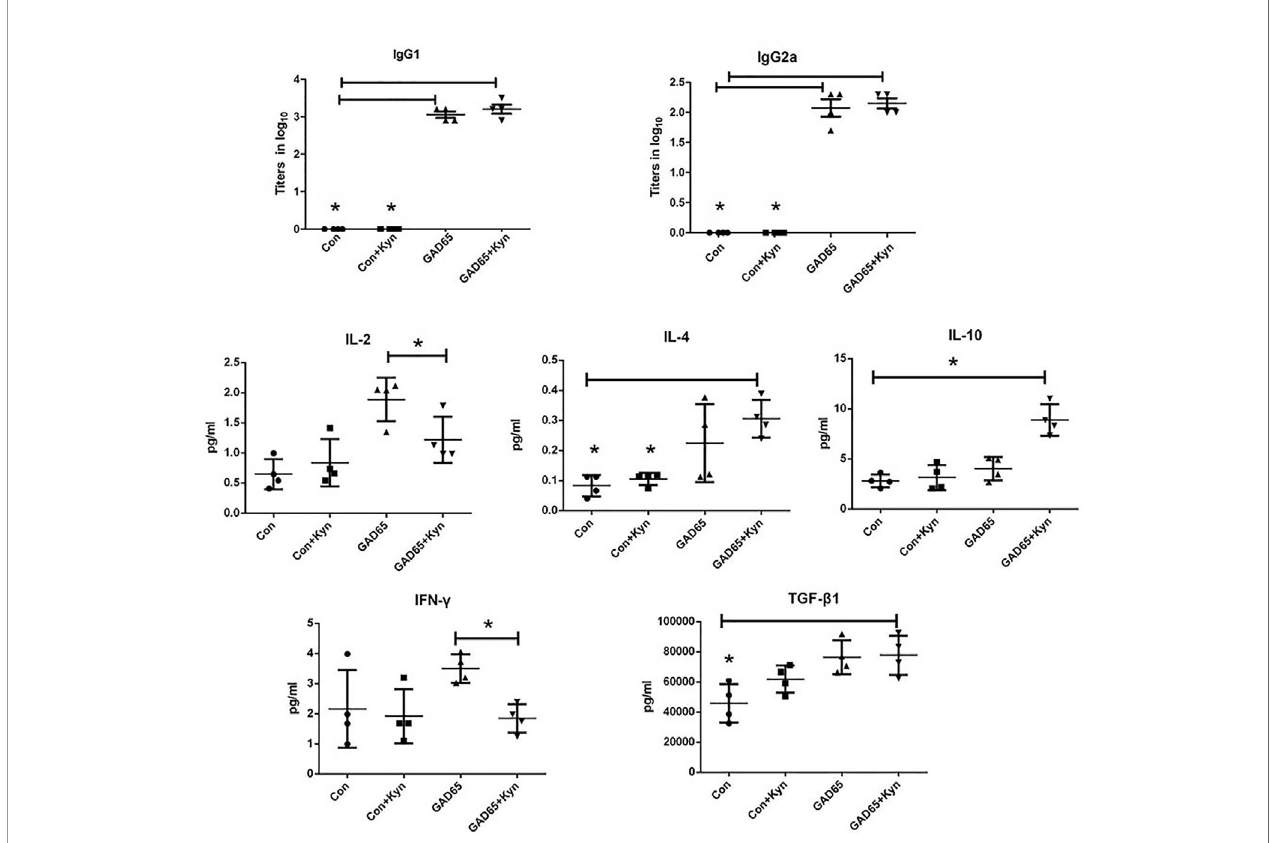
FIGURE 3 | Sera samples were collected to detect cytokines with MSD electochemiluminescence. GAD65 phage vaccine co-immunized with KYN generated signi fi cantly lower secretion of IL-2, IFN- g than the GAD65 phage group did, and higher secretion of IL-10, IL-4, TGF- b 1, than any other groups did (*P <